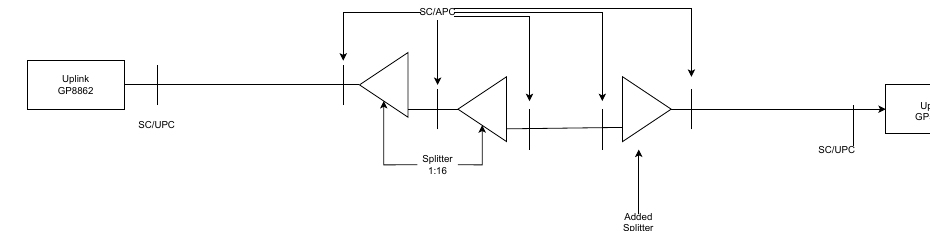
Figure 4. GPON—time of attack measurement setup.